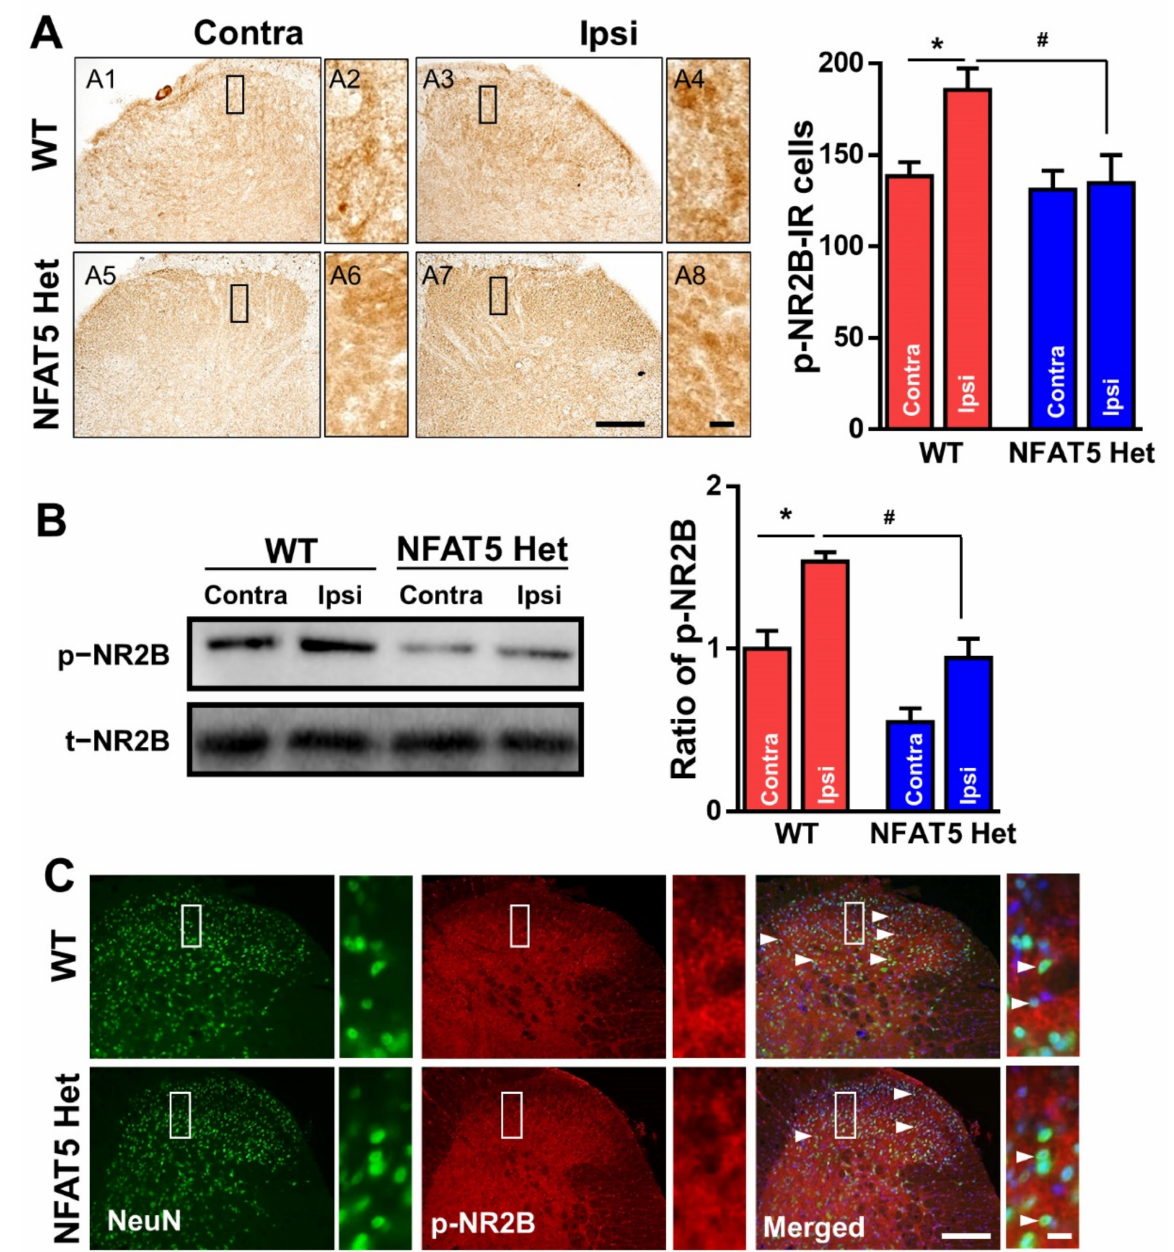
Figure 5. Formalin-induced phosphorylation of NR2B in the spinal dorsal horns of WT and NFAT5-Het mice. ( A ) At 1 h post-formalin injection, spinal tissues (lumbar (L) 4–6 fragments) from WT and NFAT5-Het mice were incubated with anti-p-NR2B antibody. Scale bar: 50 µ m (left), 20 µ m (right). The numbers of p-NR2B-immunoreactive (IR) cells were analyzed in contralateral (contra) and ipsilateral (ipsi) sides of the spinal dorsal horn in WT and NFAT5-Het mice. Data are expressed as the means ± SEMs (one-way ANOVA with Tukey’s post-hoc test, * p < 0.05 vs. WT contra, # p < 0.01 vs. WT ipsi, n = 5). ( B ) The expression level of p-NR2B in the spinal cord (L4–6) was also inspected by Western blot analysis. Band intensities represented as the ratio of p-NR2B normalized to total (t)-NR2B. Data are expressed as the means ± SEMs (one-way ANOVA with Tukey’s post-hoc test, * p < 0.05 vs. WT contra, # p < 0.05 vs. WT ipsi, n = 5). ( C ) Frozen sections from (A) above were stained with anti-p-NR2B and anti-NeuN antibodies. Arrow heads indicate p-NR2B/NeuN-positive cells. Scale bar: 50 µ m (left), 20 µ m